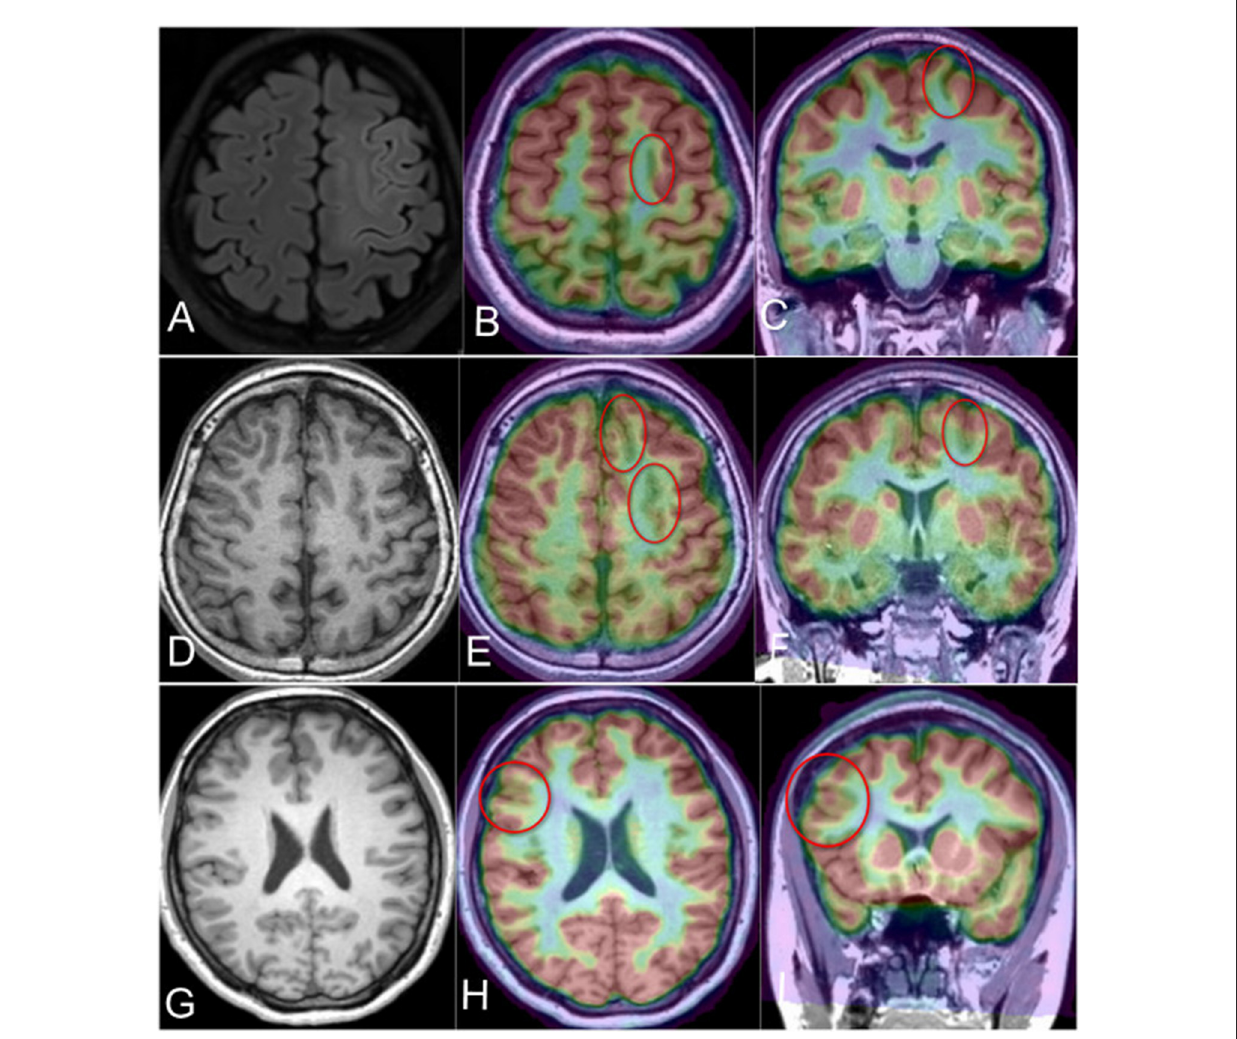
FIGURE3 PET-MR co-registration in the MR-positive or MR-negative cases in different groups. (A) Case 4 in the PS group; the axial flair scan demonstrated the abnormal signal and gray-white matter blurring in the posterior part of left SFS (MR-positive), (B, C) the PET-MR co-registration image (axial and coronal) revealed the hypometabolism foci in the same location of MR image; (D) demonstrated the MR-negative Case 3 in the AS group, (E, F) showed the hypometabolism of the left SFS and adjacent sulcus (red circles); (G) demonstrated the T1-negative image of Case 2 in the NS group; (H, I) revealed the hypometabolism area in the right inferior frontal sulcus related lobule (red